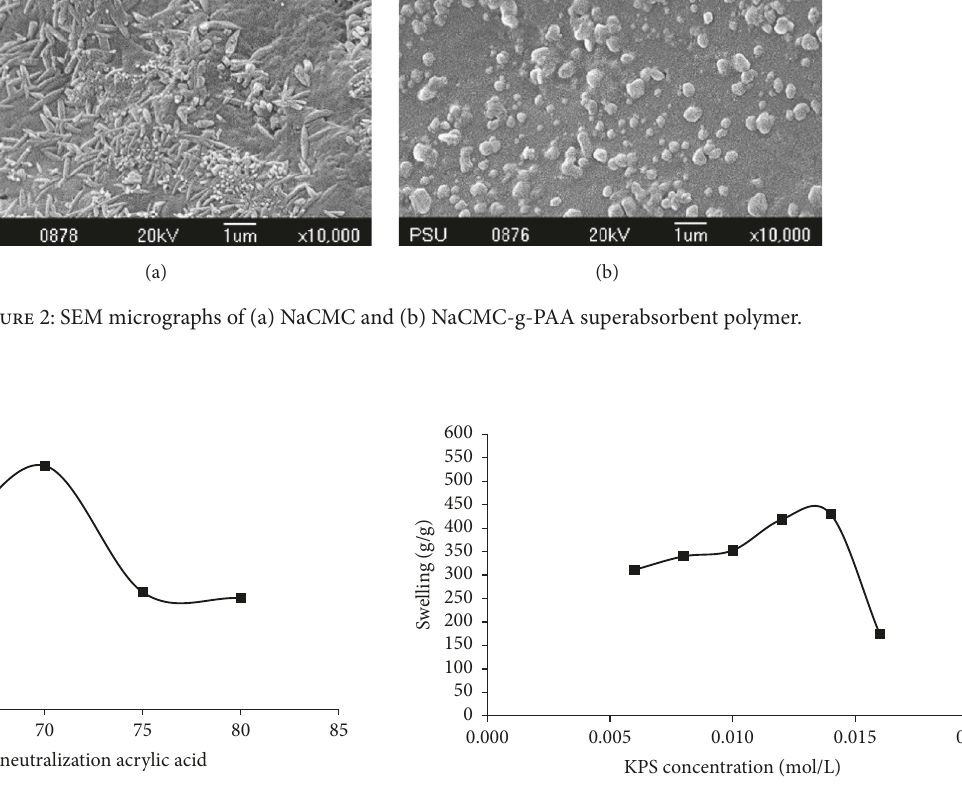
Figure 3: Effect of partially neutralized acrylic acid on swelling (reactioncondition:2.0 g/100 mLNaCMC,0.8mol/LAA,0.01 mol/L KPS, and 0.01 mol/L MBA 70 ∘ C for 90 min).